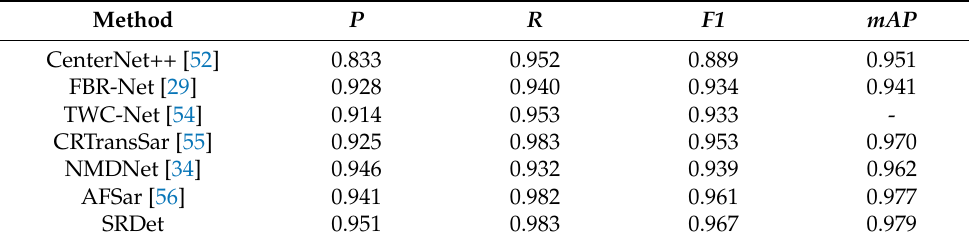
Table 10. Comparison with SAR ship detection methods on SSDD.